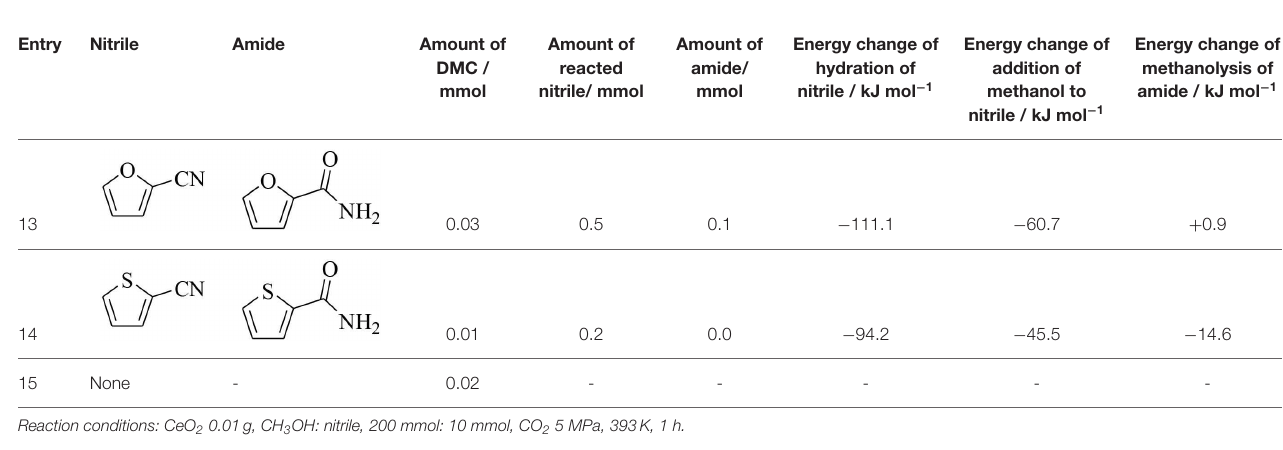
Frontiers in Energy Research |